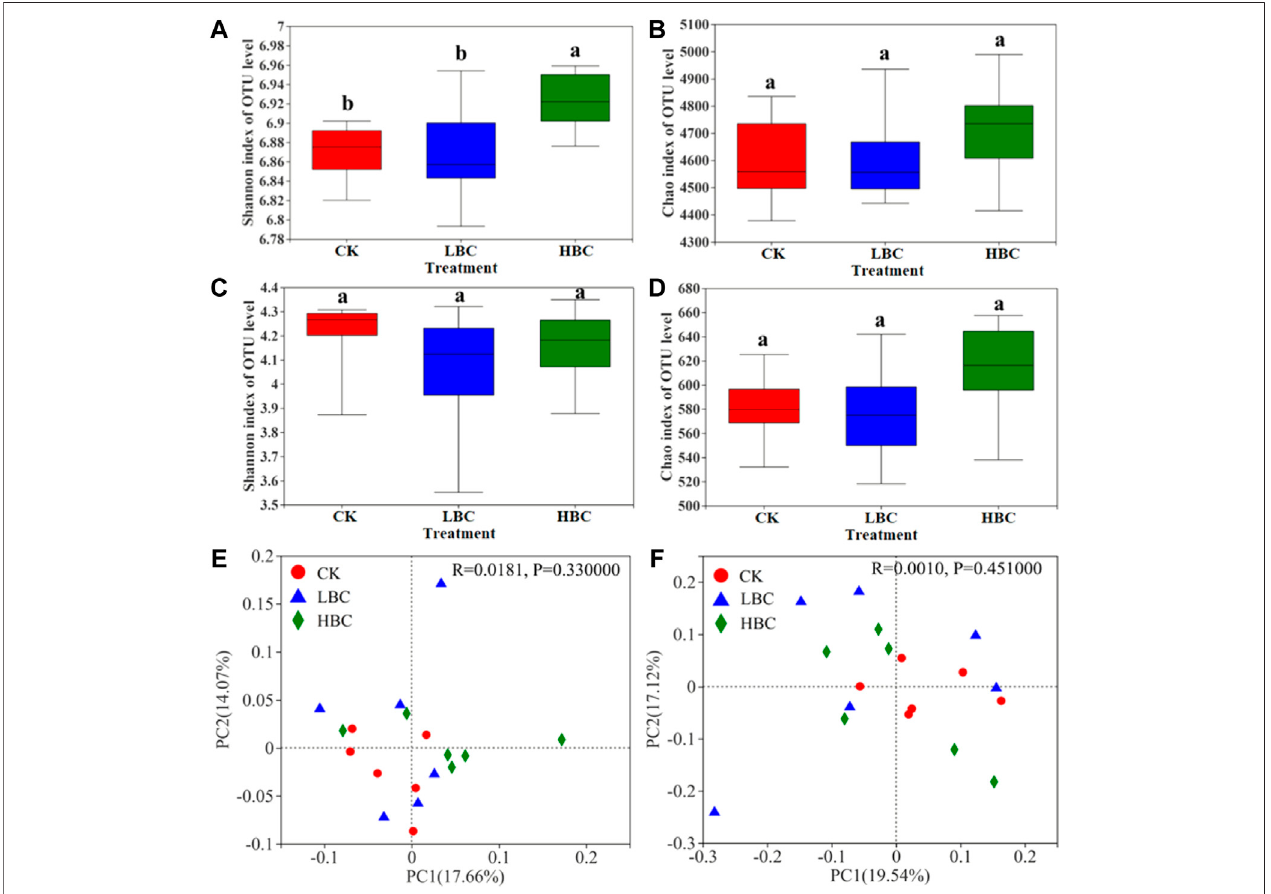
FIGURE1 | Bacterial and fungal diversity (at the OUT level) of the coastal saline soil with or without biochar amendment. Alpha diversity was revealed by the Shannon index for bacteria (A) and fungi (C) , and Chao one index for bacteria (B) and fungi (D) . Bars (n = 6) with different letters show signi fi cant difference ( p < 0.05). Betadiversityofbacteria (E) andfungi (F) wasrevealedbyPCoAbasedontheBray – Curtisdistance.CK,soilwithoutbiocharamendment;LBC,soilamendedwithalow amount of biochar at 18 t/ha; HBC, soil amended with a high amount of biochar at 36 t/ha.